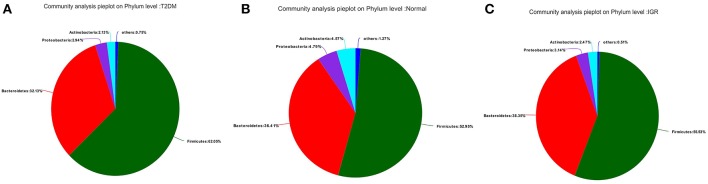
Pie charts of gut microbiota at phylum level in three groups. (A) T2DM group (B) NC group (C) IGR group.